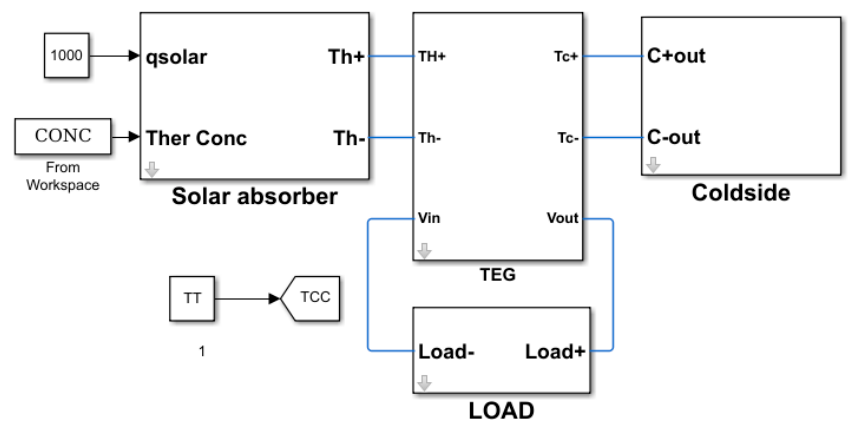
Figure 3. First level of STEG Simulink. Solar absorber, TEG, cold side, and load are four masked parts of a STEG system. The TC and cold side temperature can be fed from the Matlab workspace while other parameters are set inside the simulink.